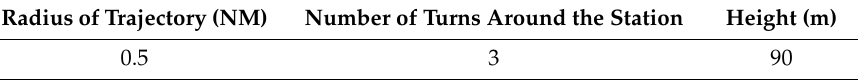
◦ Table 8. Height equal 90 m corresponds to an elevation angle of 5.5 to the chosen mission radius, ◦ ◦ which is within the limits, between 4 and 6 , established by regulation [23]. Table 8. Misalignment error as a function of the trajectory